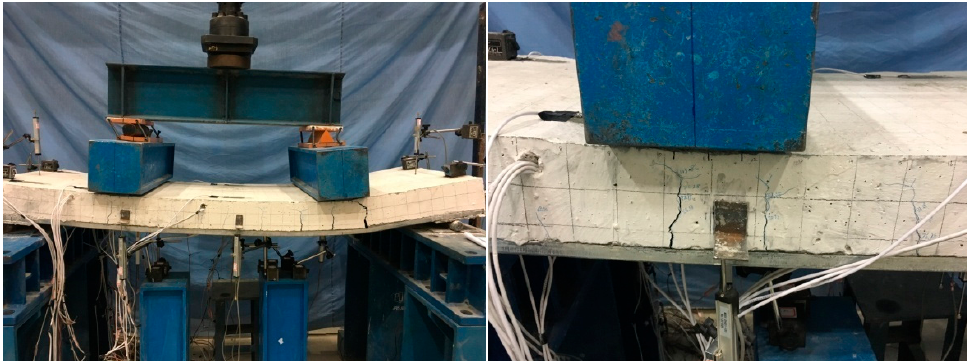
Figure 10. Typical failure modes of composite slab specimens (for SCLC-B-1).